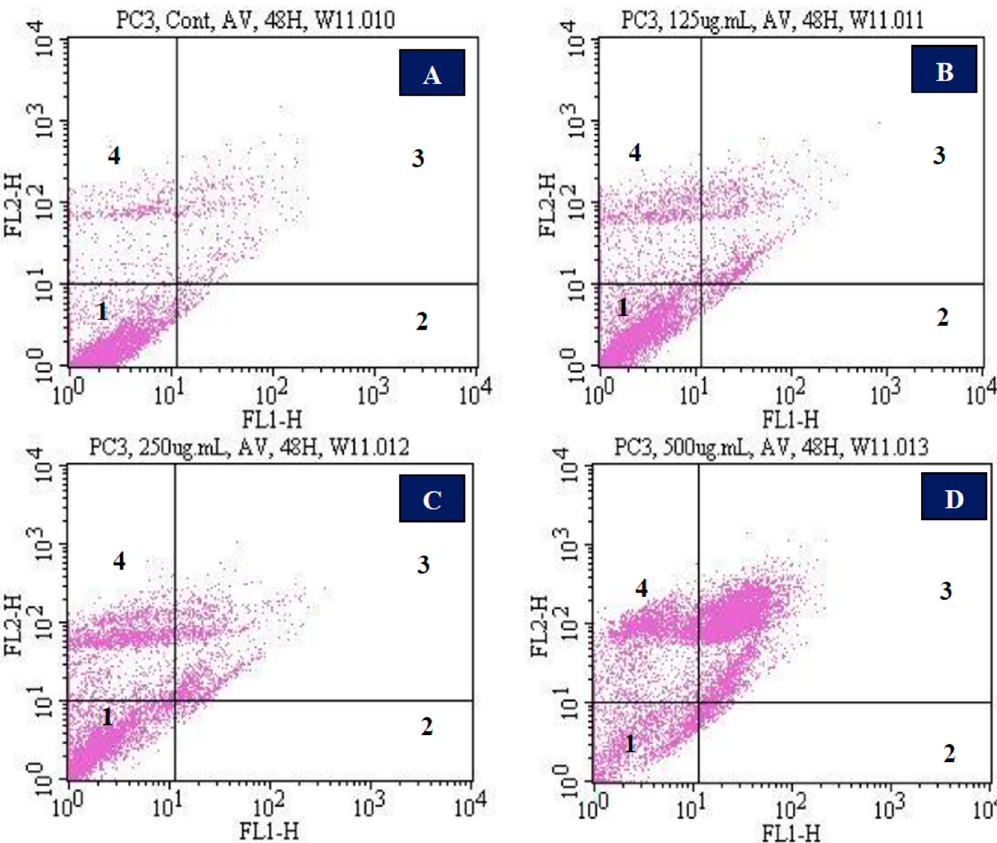
Figure 6. Representative dot plots showing the apoptotic and necrotic potential of Vernonia amygdalina Delile (VAD) in PC-3 cells upon 48 h of extract exposure. ( A ): Controls (untreated); ( B ): 125 µg/mL VAD; ( C ): 250 µg/mL VAD; ( D ): 500 µg/mL VAD. Quadrant 1: Live cells or annexin V- and PI-negative cells; 2: Early apoptotic or annexin V-positive cells; 3: Late apoptotic and necrotic or annexin V- and PI-positive cells; 4: Necrotic or PI-positive cells.